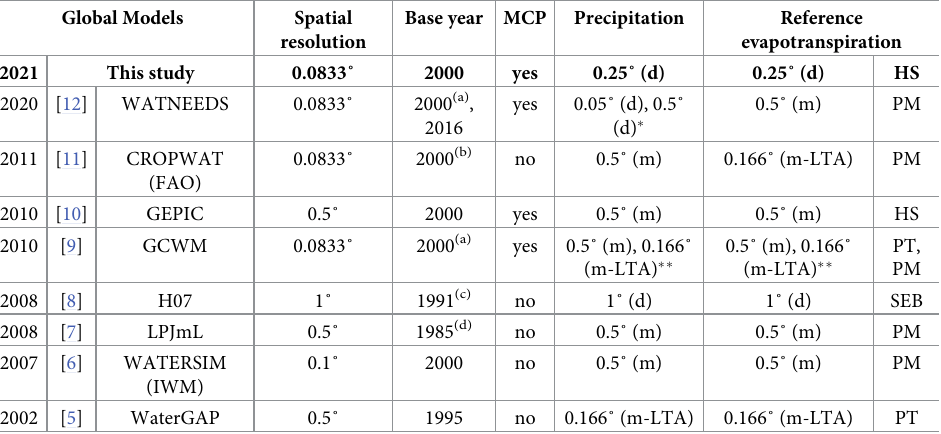
Table 1. Summary of models that estimate global irrigation